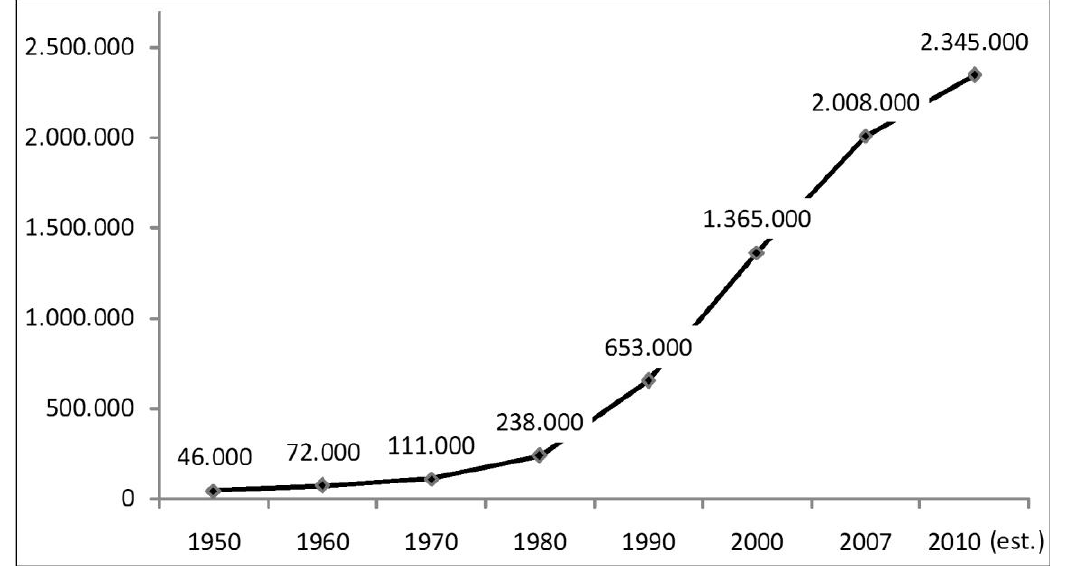
Figure 1. Population growth of Sana’a from 1950 to 2010